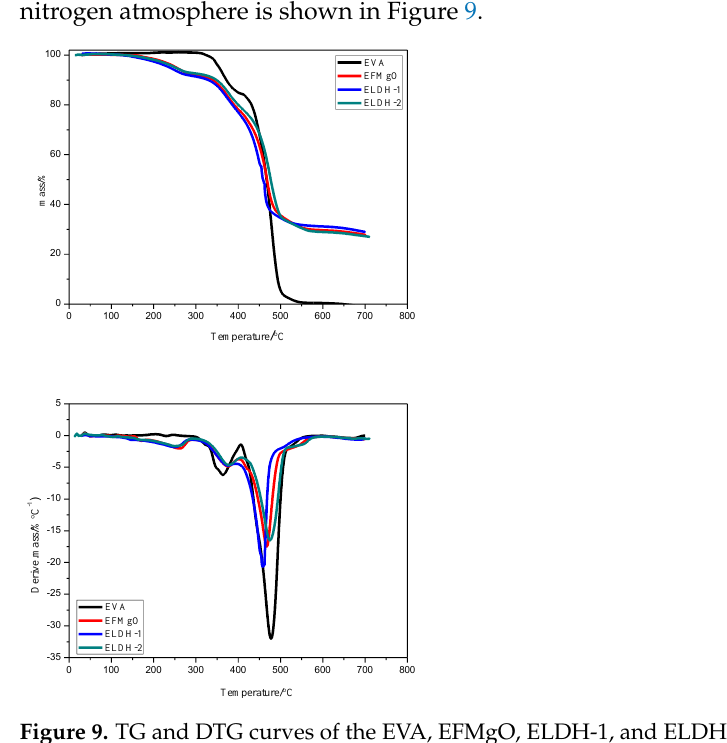
Figure 9. TG and DTG curves of the EVA, EFMgO, ELDH-1, and ELDH-2 composites. TG analysis. When applied as a flame retardant, the thermal stability of polymers plays an essential role, which is closely linked to the release of decomposition products and char formation. Mass loss of polymers was caused by the volatilization of products generated by thermal decomposition, which was monitored as the function of a temperature ramp. The related results are given in Figure 9 and Table 4. EVA in Figure 9